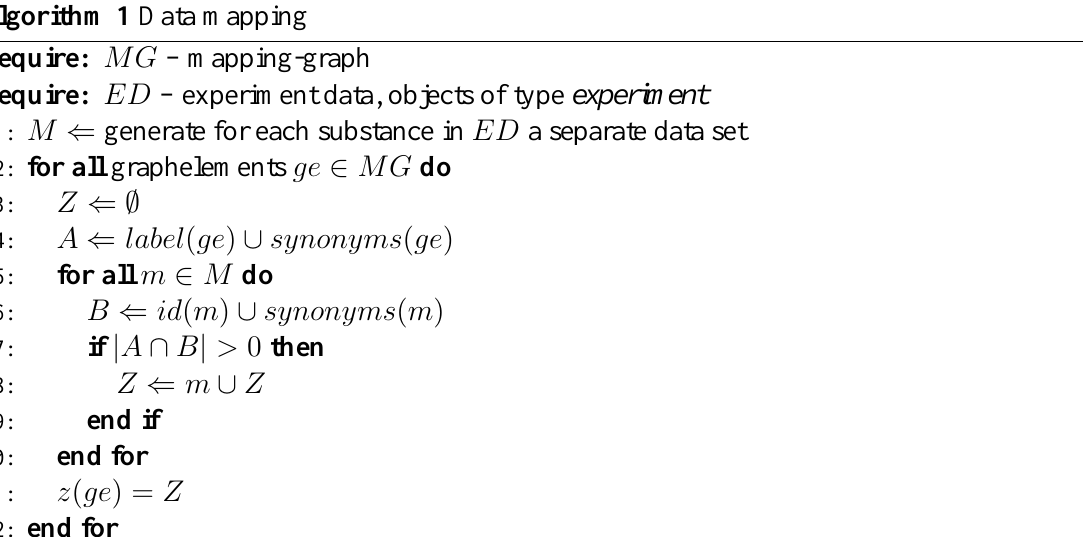
Algorithm 1 Data